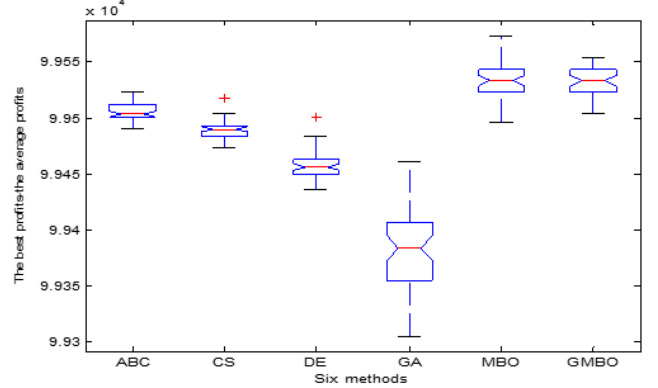
Figure 18. Boxplot of the best values on KP15 in 50 runs.